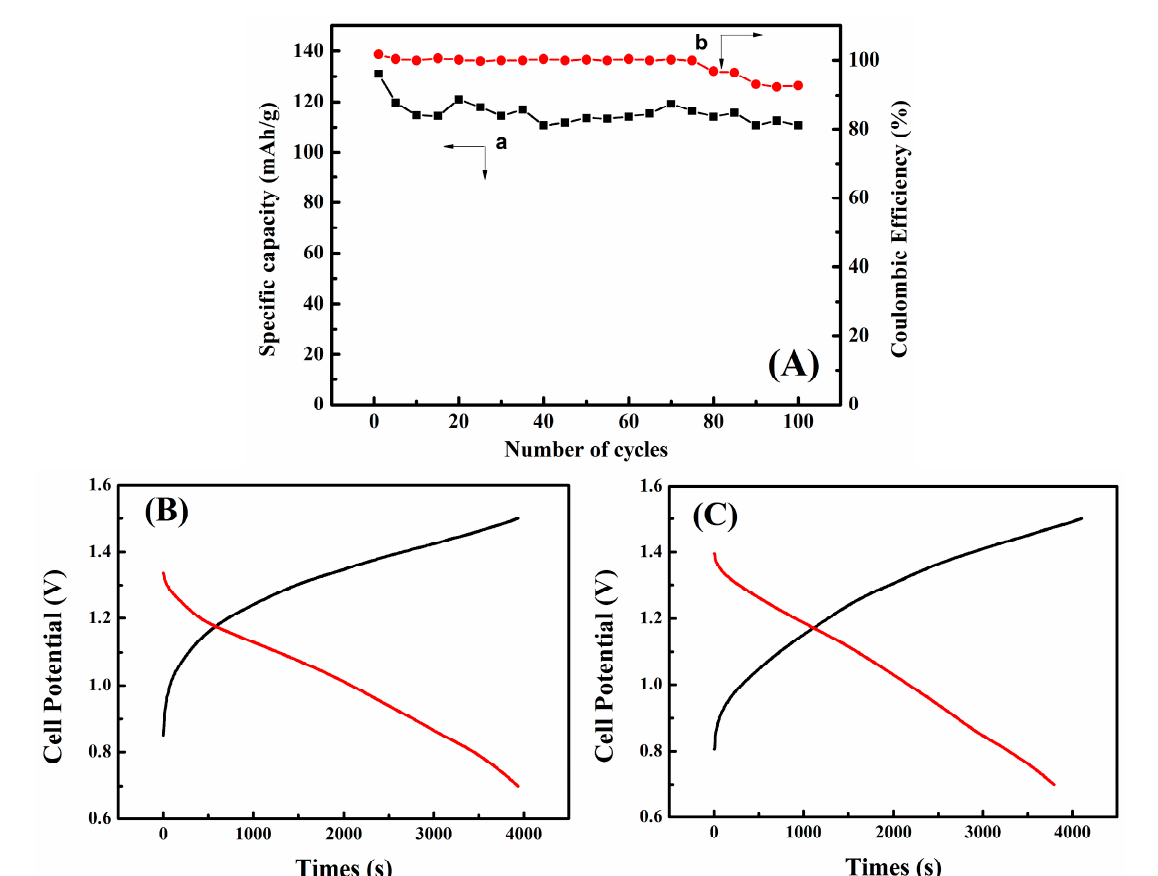
Figure 11. In 100 cycles, the specific capacity and the coulombic efficiency of the Zn ‐ PANI battery vary with the number of cycles ( A ), the charge and discharge curves of the 10th cycle ( B ) and the 100th cycle ( C ).